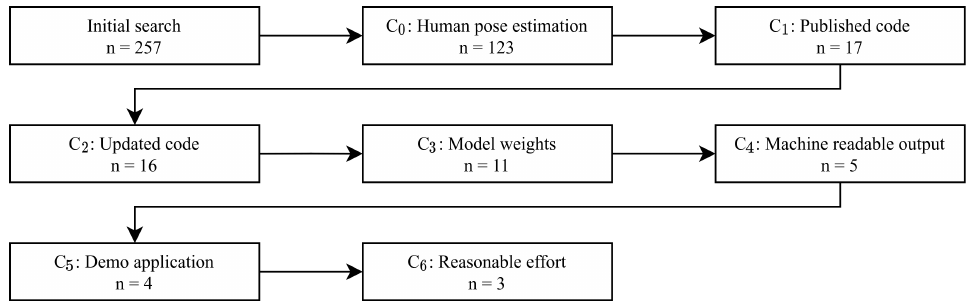
Figure 2. The algorithm selection process. Starting with an initial search, n = 257 algorithms are considered. After applying C 0 –C 6 , finally n = 3 papers